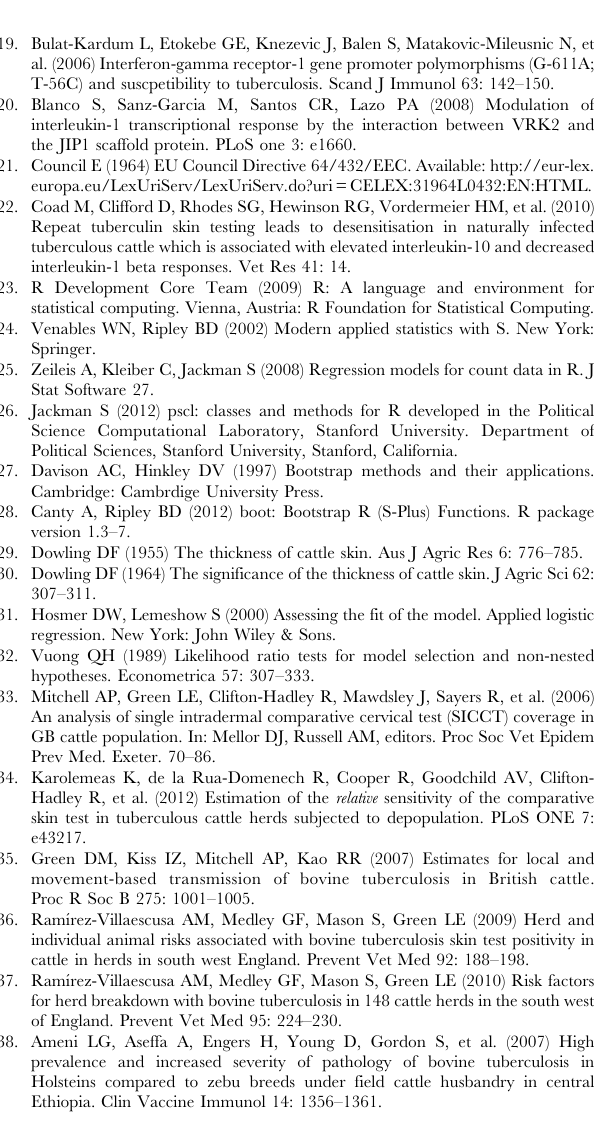
Table S2 Prediction of avian skin thickness measure- ment (a2) by ‘22’ genotype. Summary of a Poisson error structure regression model exploring the association between having the ‘22’ genotype and size of the second avian skin thickness measurement (a2). Coefficients are reported to 2 significant figures, with 95% confidence intervals. Significant associations at the 95% level are highlighted in bold. Breed effects are measured relative to the Holstein Breed (HOL) that is the most represented breed within the study population. Table S3 Prediction of bovine skin thickness measure- ment (b2) by ‘22’ genotype. Summary of a Poisson error structure regression model exploring the association between having the ‘22’ genotype and size of the second bovine skin thickness measurement (b2). Coefficients are reported to 2 significant figures, with 95% confidence intervals. Significant associations at the 95% level are highlighted in bold. Breed effects are measured relative to the Holstein Breed (HOL) that is the most represented breed within the study population.